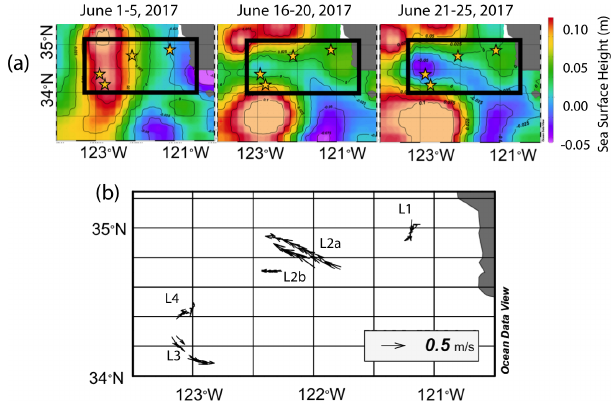
Figure 4. (a) Average sea surface height from 1–5, 16–20, and 21– 25 June 2017. In the beginning of June, sea surface height was low near the shore due to Ekman transport and higher off the